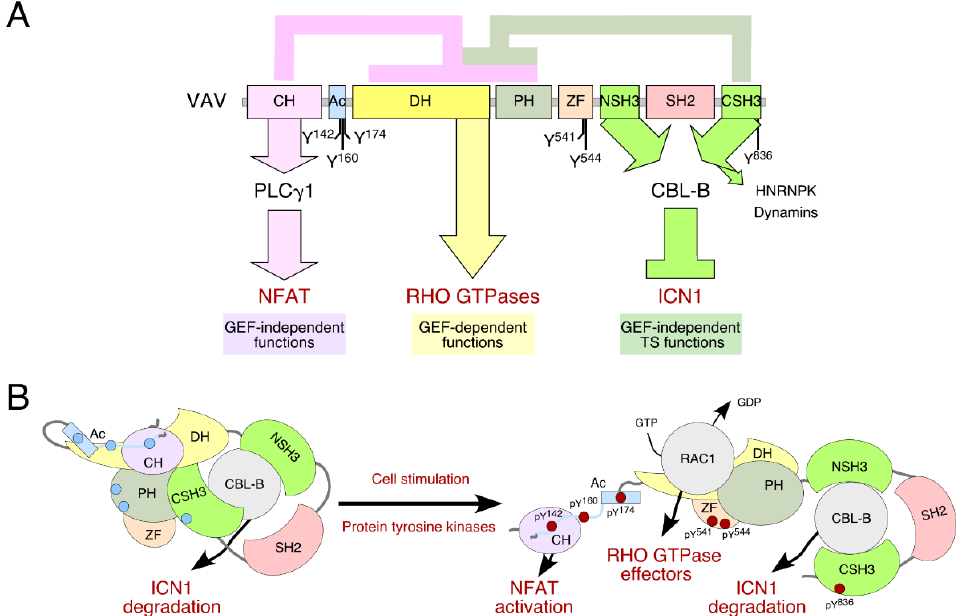
Figure 1. Structure and effector activities of VAV proteins. ( A ) Depiction of the structure of VAV proteins, the intramolecular interactions that control their biological activities (top), the main phos- phosites involved in the activation step, and the main downstream pathways (bottom) activated by the indicated domains. The numbering refers to the sequence of VAV1. CH, calponin-homology; Ac, acidic; DH, Dbl-homology; PH, pleckstrin-homology; ZF, zinc finger; NSH3, most N-terminal SH3 domain; CSH3, most C-terminal SH3; TS, tumor suppressor. ( B ) Phosphorylation-mediated activation model of VAV proteins. The autoinhibited state of nonphosphorylated VAV proteins is stabilized by intramolecular contacts of the CH and CSH3 domains with the catalytic core DH-PH-ZF. Upon phosphorylation of tyrosine residues, the autoinhibited structure is released. Note that the suppressor activity of VAV that contributes to the control of NOTCH1 levels can be fully engaged by both the inactive and active versions of the protein. Nonphosphorylated and phosphorylated residues are shown as blue and red circles, respectively. Color codes for VAV domains are those used in panel A.